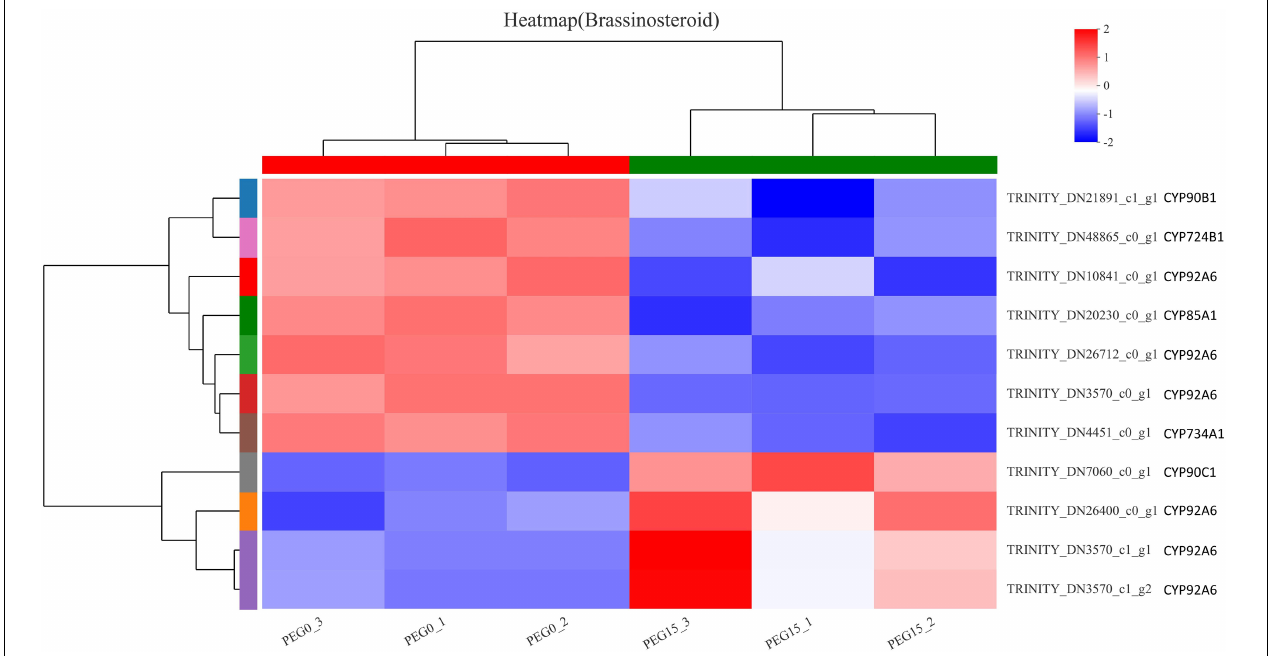
release of ARF protein and the expression of SAUR, thus affecting plant growth of